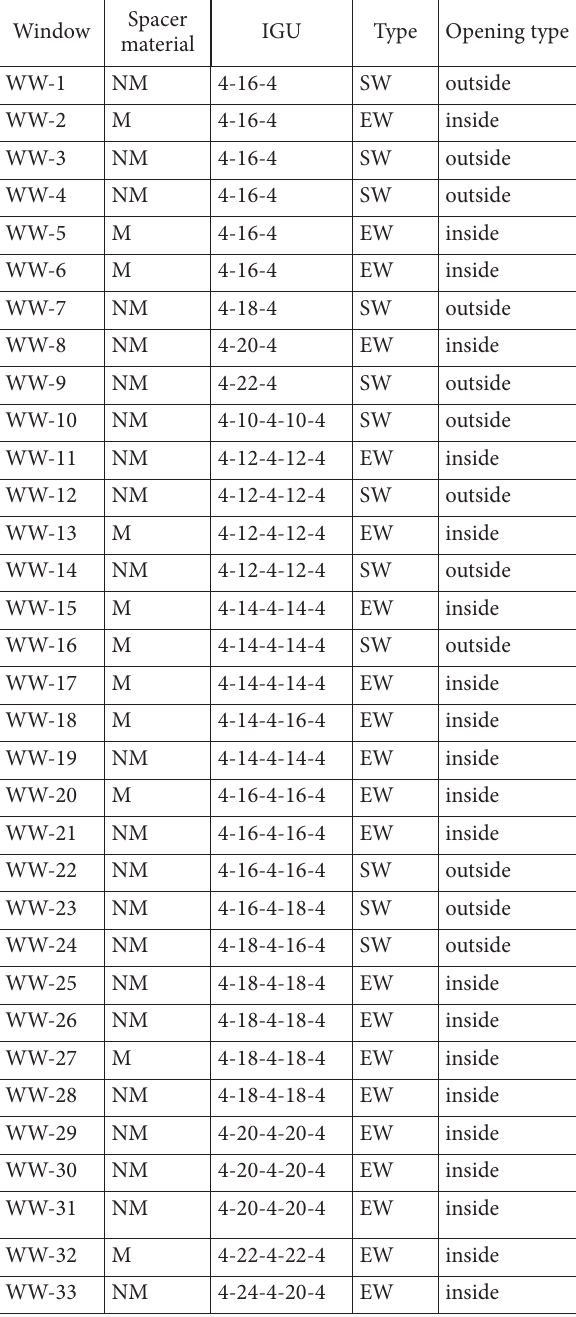
Table 1. Tested windows